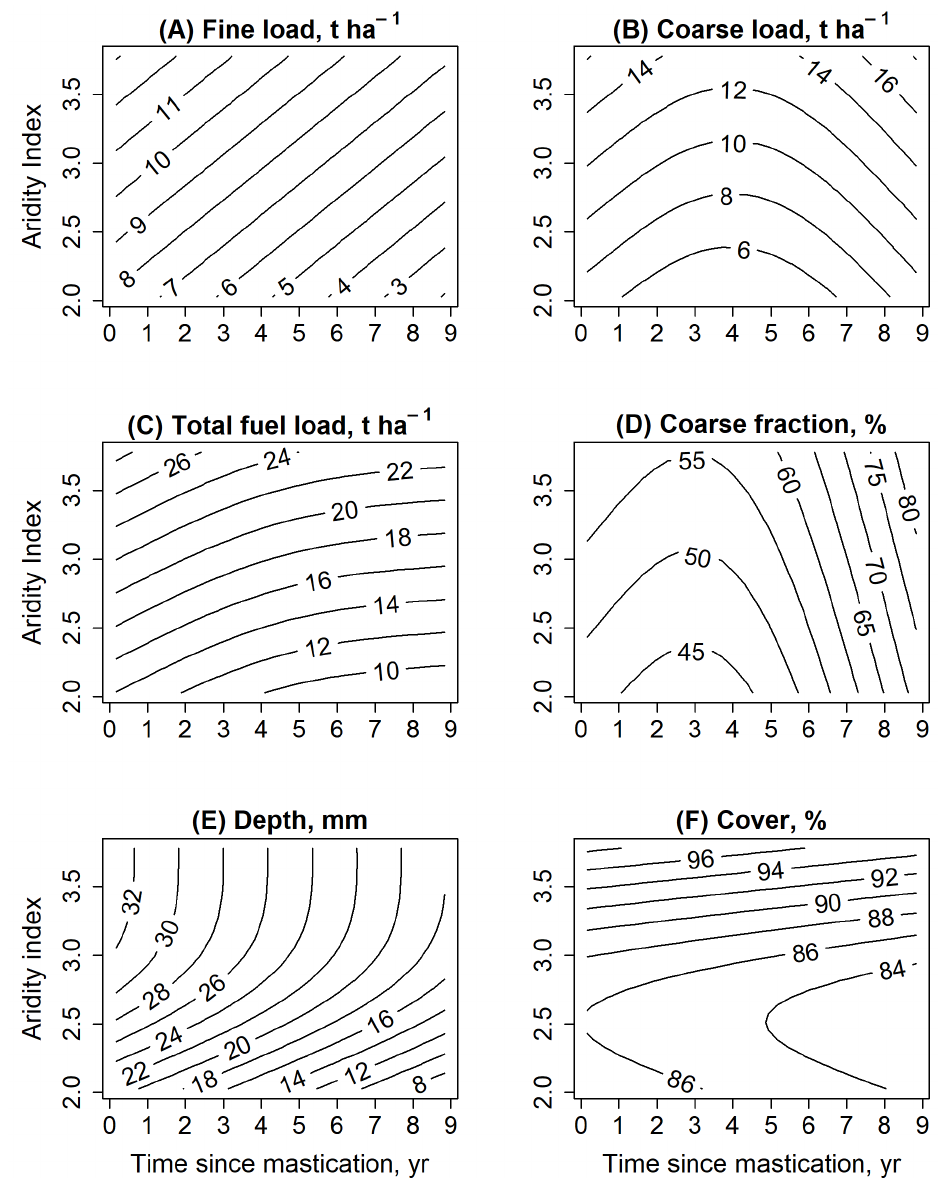
Figure 3. Contour plot showing surface fuel properties as a function of time since mastication and aridity as predicted by the GAM for: ( A ) fine load; ( B ) coarse load; ( C ) total load; ( D ) coarse fraction; ( E ) depth; and ( F ) cover. Values represent the predicted response value with units in the figure title.